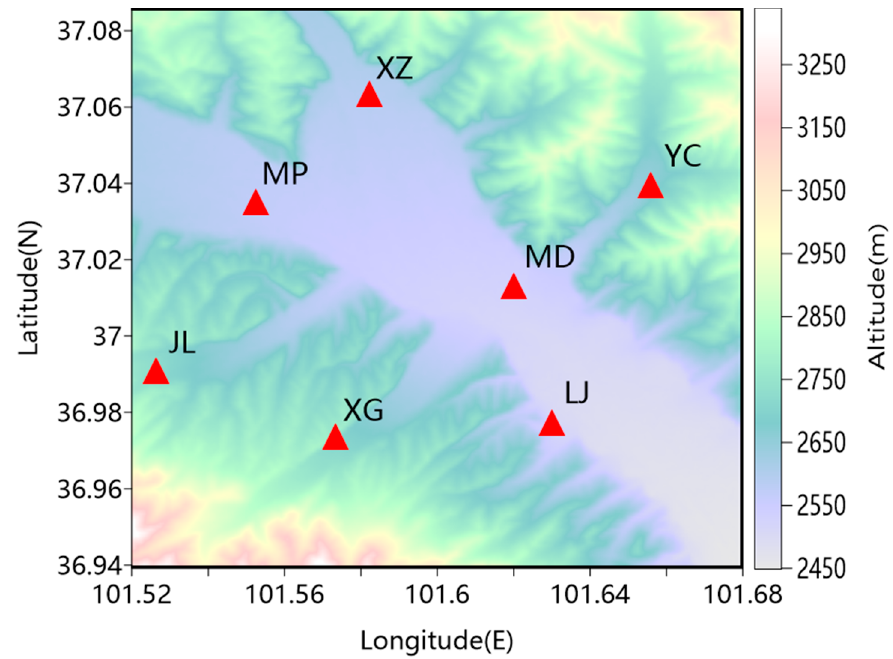
Figure 1. The seven stations of the 3D lightning radiation source location system in the Datong region of Qinghai Province, China.